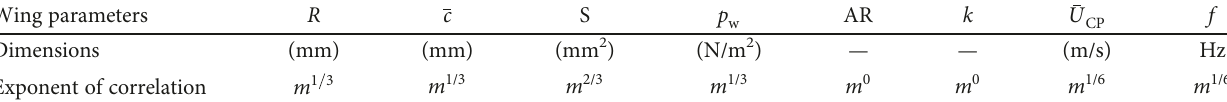
Table 2: Power function of wing parameters against body mass. The exponent of correlations is for (mass) exponent .